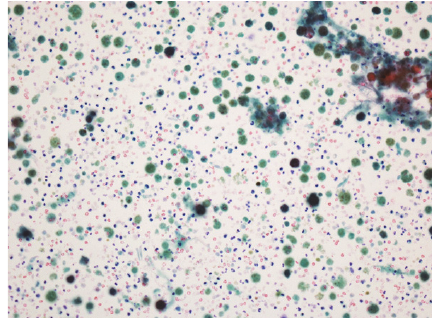
Figure 3: Cytologic features of the collected fluid by fine-needle aspiration ( ×